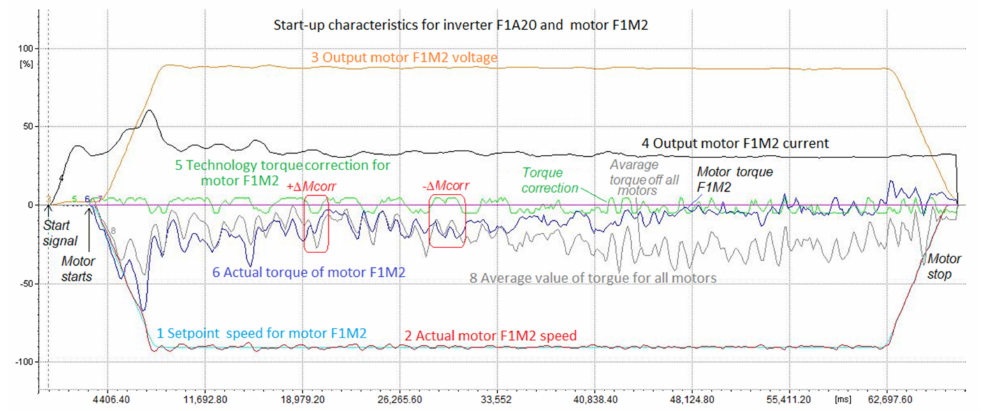
Figure 9. Starting curves of the F1M2 stacker motor with torque correction. In Figure 10 all curves (marked with numbers from 1 to 8) are given on the same percentage scale, related to the rated nominal values and quantities defined in the inverter parameter system.